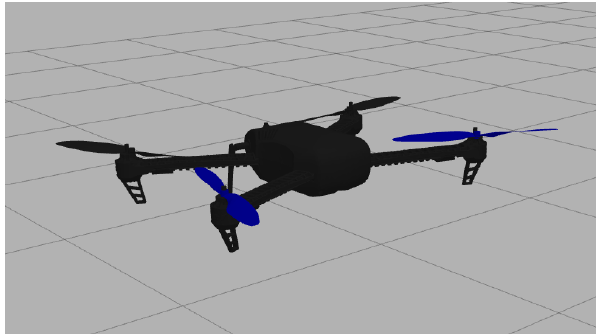
Figure 4. Iris quadrotor UAV model in Gazebo